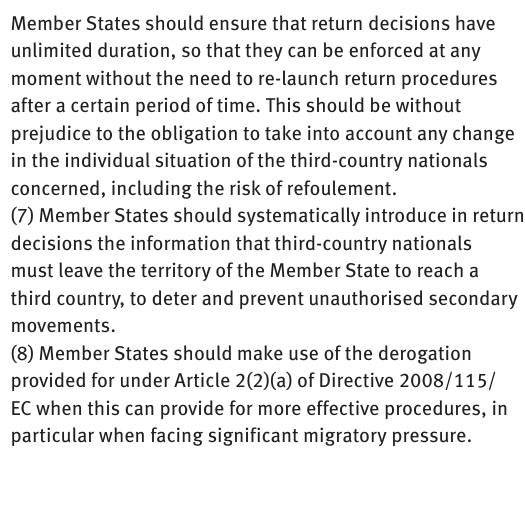
Table 3: Text 2 (original text in English and machine translation into Spanish)